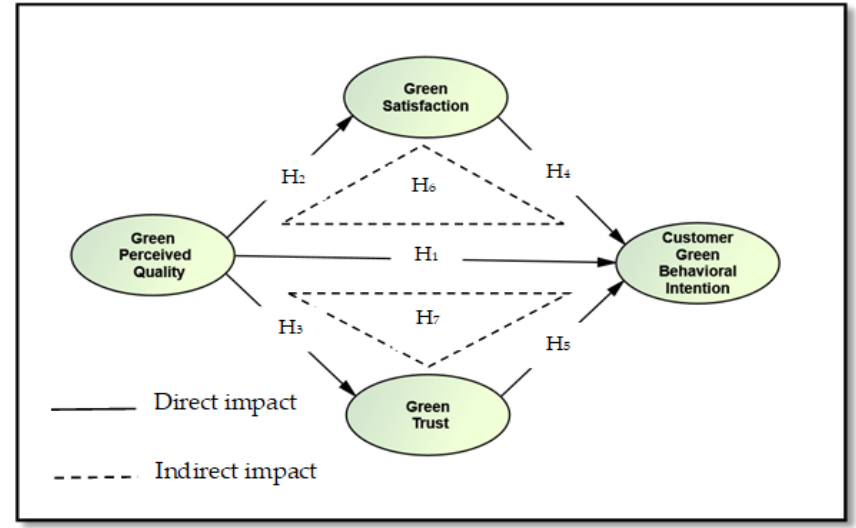
Figure 1. The proposed conceptual framework .